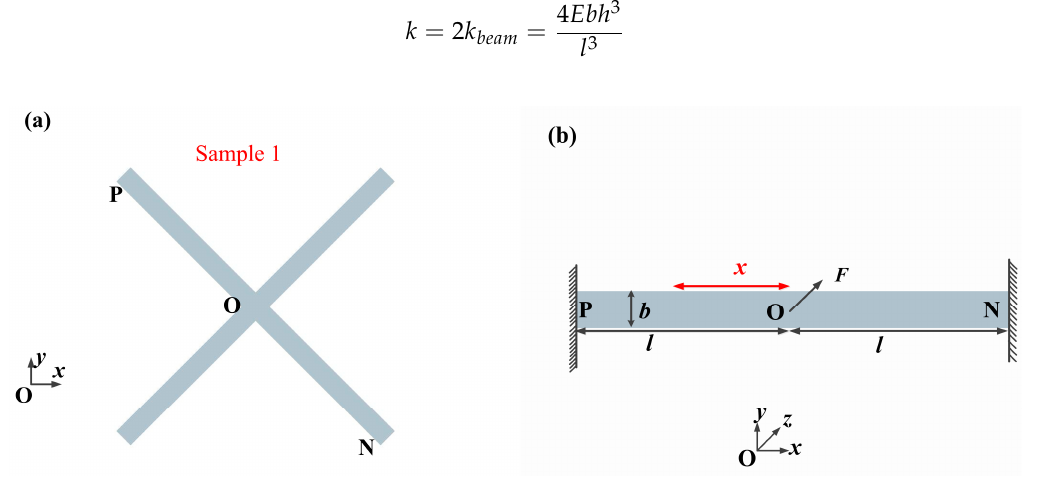
Figure 1. ( a ) Two-dimensional sketch of the stationary electrode in sample 1; and ( b ) the plane structure diagram of the cantilever beam in sample 1.